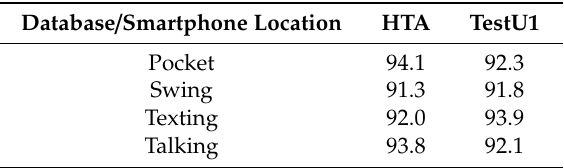
Table 7. Test accuracy results when training on the TrainU1 dataset with the CNN architecture while using only accelerometer